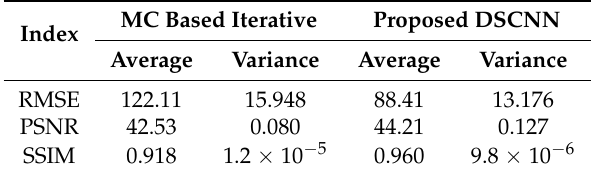
Table 4. Comparison of reconstructed images after scatter correction.